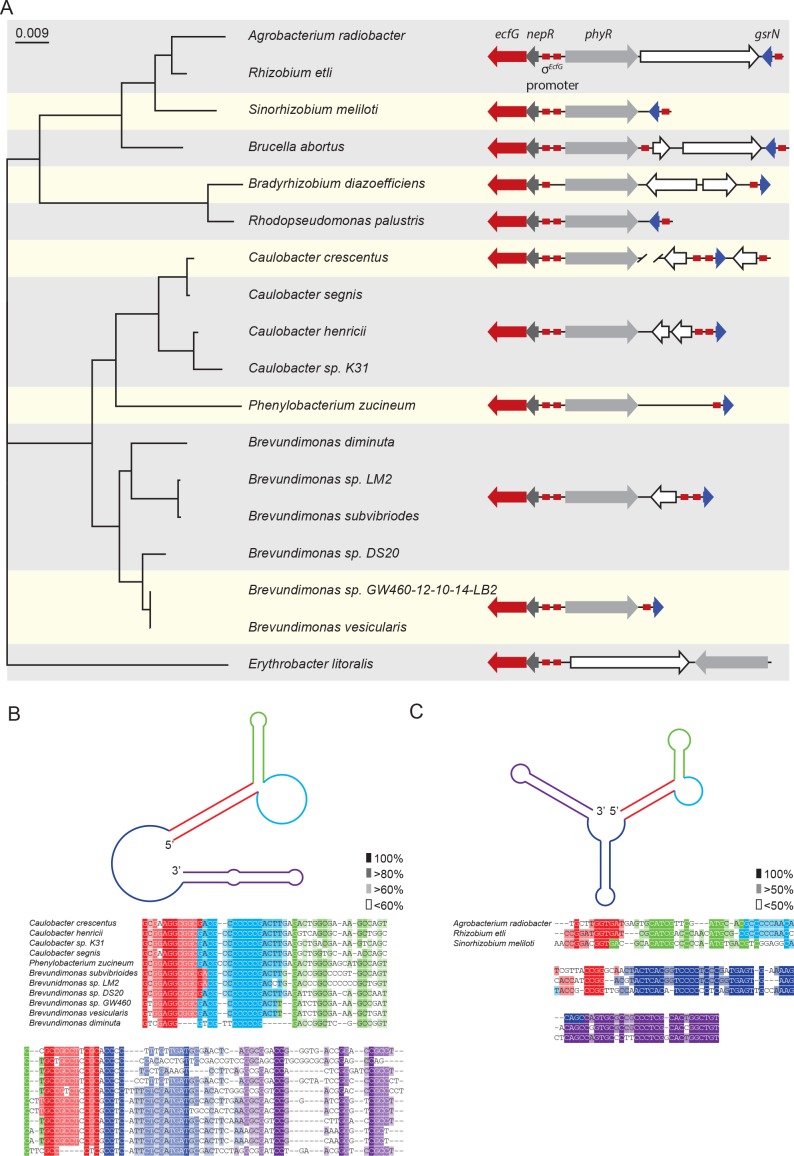
Conserved features of GsrN homologues.(A) Locus diagrams showing predicted gsrN homologs in several Alphaproteobacteria. Tree was constructed from the 16 s rRNA sequences of each strain where Erythrobacter litoralis (for which there is no apparent gsrN-like gene) was the out-group. Red arrows represent ecfG, dark gray arrows represent nepR, light gray arrows represent phyR, and dark blue arrows represent gsrN (or its putative homologs). Red boxes represent the conserved σecfG-binding site. The prediction of GsrN orthologs in the Caulobacteraceae (Caulobacter, Brevundimonas, and Phenylobacterium) was based on a BLASTn search (Altschul et al., 1990). The prediction of GsrN in Rhizobium etli, Sinorhizobium meliloti, and Brucella abortus was based on evidence of GSR-dependent expression in published transcriptome data, proximity to the GSR locus, and identification of a σecfG-binding site upstream of the gene. The prediction of Agrobacterium radiobacter was based on a BLASTn search of using the predicted GsrN sequence from R. etli as the query (Altschul et al., 1990). The prediction of Rhodopseudomonas palustris and Bradyrhizobium diazoefficiens is solely based on the proximity to the GSR locus and the presence of an upstream σecfG-binding site. (B) Diagram of predicted secondary structure of GsrN in other Caulobacteraceae is colored by secondary structure element. Colors highlighted in the sequence alignment correspond to the predicted secondary structure regions in the cartoon. Density of shading corresponds to conservation at that position. (C) Diagram of predicted secondary structure of predicted GsrN homologs in select Rhizobiaceae where the 5’ portion contains an unpaired 5’ G-rich loop (cyan) flanked by a small hairpin (green) and a stem loop involving the 5’ terminus (red).